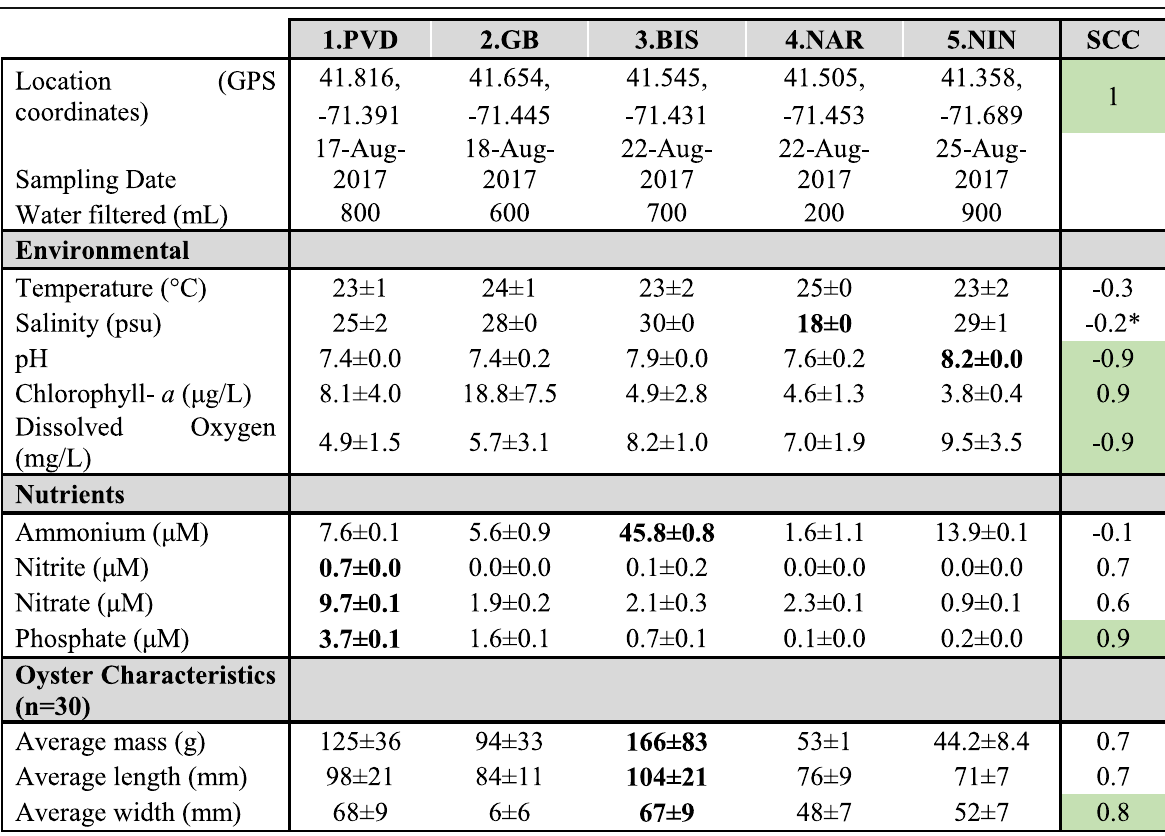
Table 1 Summary of all measurements collected per site. Environmental values are daily averages ± standard deviation measured at each site 1 day during week of collection. Nutrient values are averages of three-point water samples collected from each site at time of oyster collection. Spearman ’ s correlation coefficient (SCC, − 1 to 1) was calculated for the association between each parameter and Latitude. The most significant SCC values (| ≥ 0.8|) are shaded green. A value closer to 1 indicates that the parameter decreases from North-South (1.PVD to 5.NIN) and a value closer to − 1 indicates that the parameter increases from North-South. A correlation coefficient of 0 means there is no linear association and that the value does not consistently change along the estuarine gradient. Significant values as compared to the other sites are indicated in bold. *Spearman ’ s correlation coefficient for Salinity without 4.NAR: